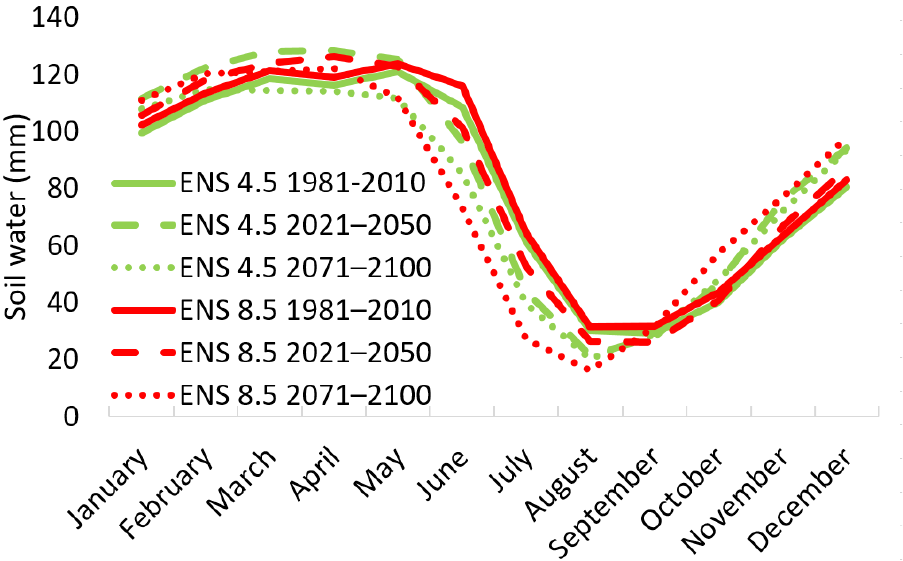
Figure 4. Soil water content for the representative monthly year for each climate model output for the reference, short- and long-term periods.